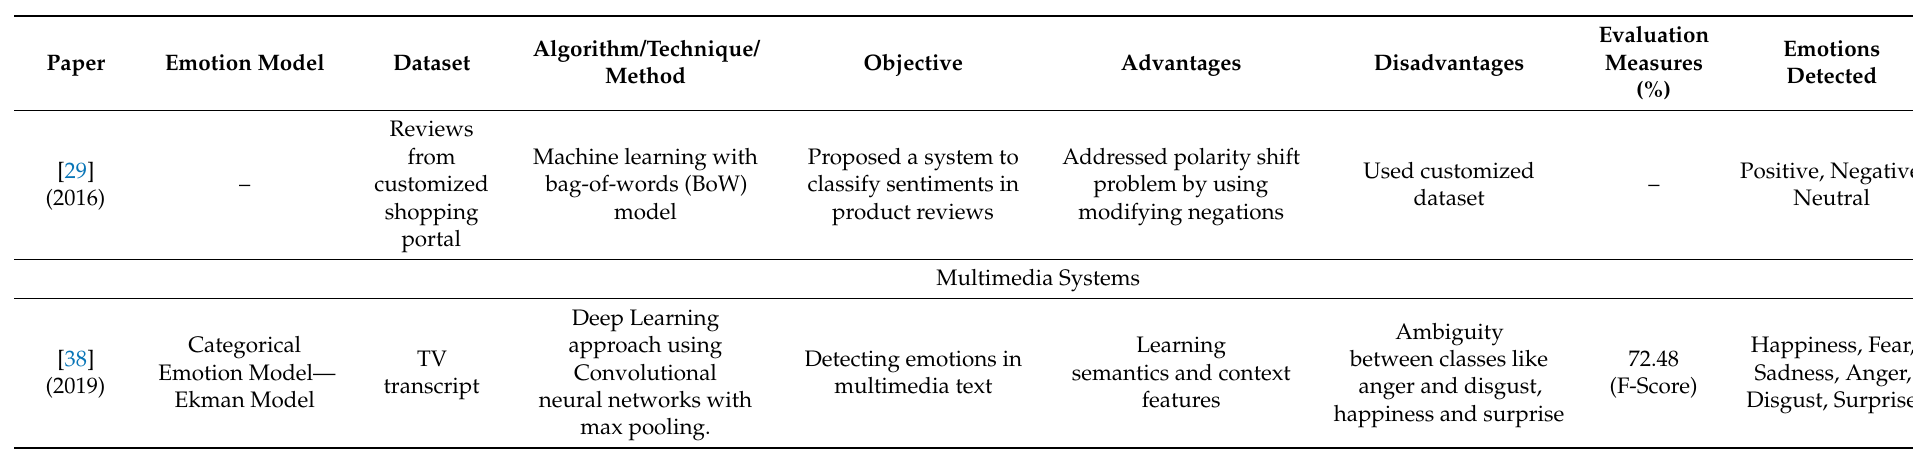
Table 3. Publicly available datasets for detecting emotions in text.